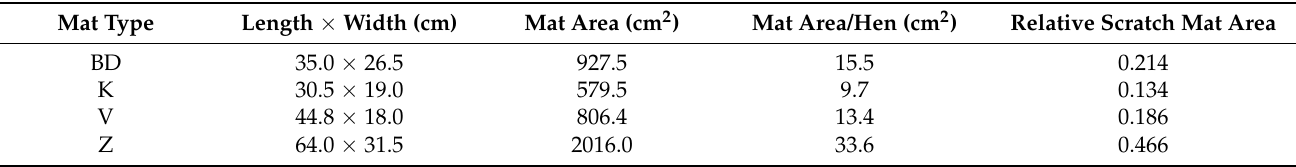
Figure 3. Image of the three test scratch mats ( a ) (from left to right) Zucami, Kovobel, and Valli and ( b ) the in situ mat (Big Dutchman); note the auger tube directly above, which provides the layer’s feed as ‘litter’. Table 1. Mat Types (BD = Big Dutchman, K = Kovobel, V = Valli, Z = Zucami) and Their Size (length × width), Total Mat Area and Area per Hen (based on 60 hens per cage, ignoring any cage mortality). Relative Area was Calculated for Later Statistical